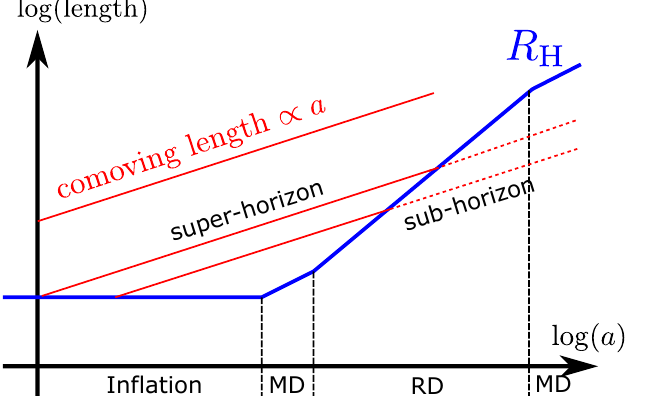
Figure 1. The rough sketch of the standard evolution of the background universe and the perturba- tions on